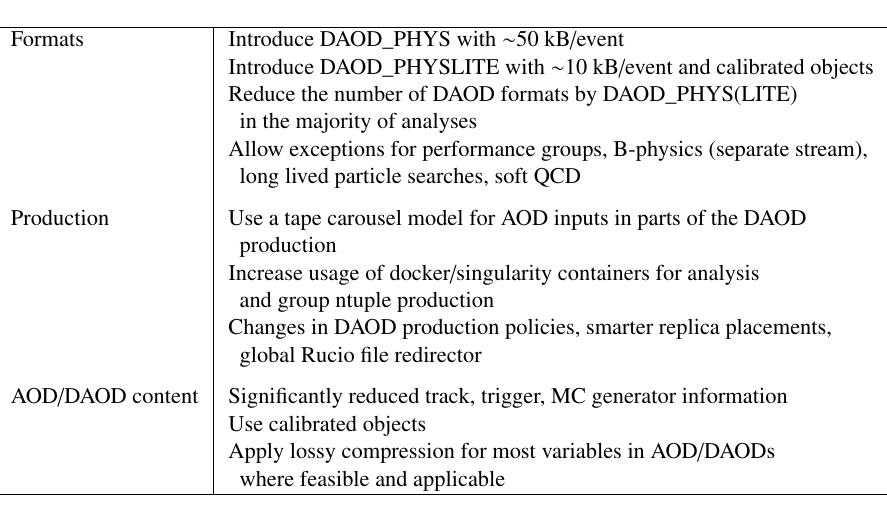
Table 2: Overview of the AMSG-R3 recommendations in di ff erent